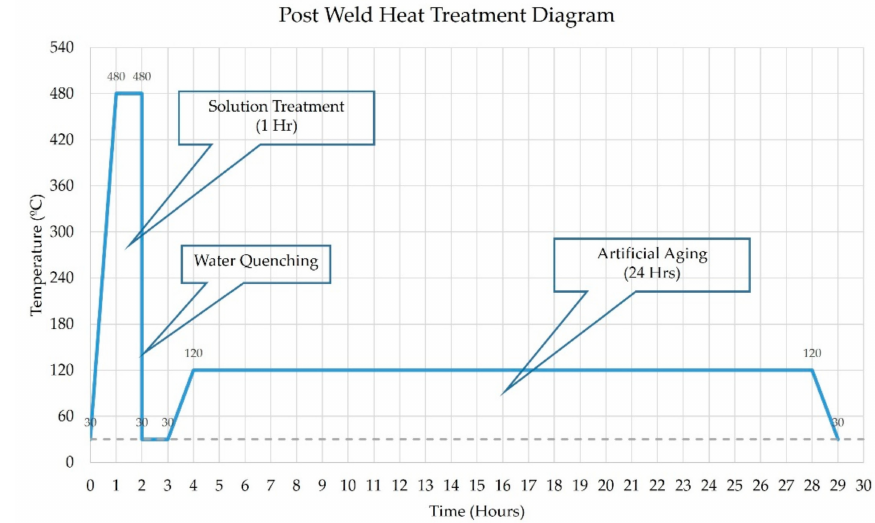
Figure 6. Post-weld heat treatment (PWHT)